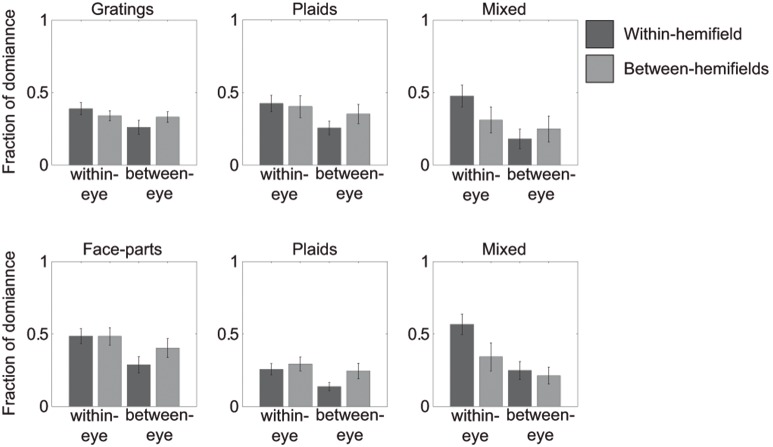
Fractions of overall dominance in Experiment 1.Within-hemifield fractions of overall dominance are presented in dark grey. Between-hemifield dominance fractions of overall are presented in light grey. Error bars represent the 95% confidence intervals. Note the overall pattern in the data is similar to the epoch duration data.